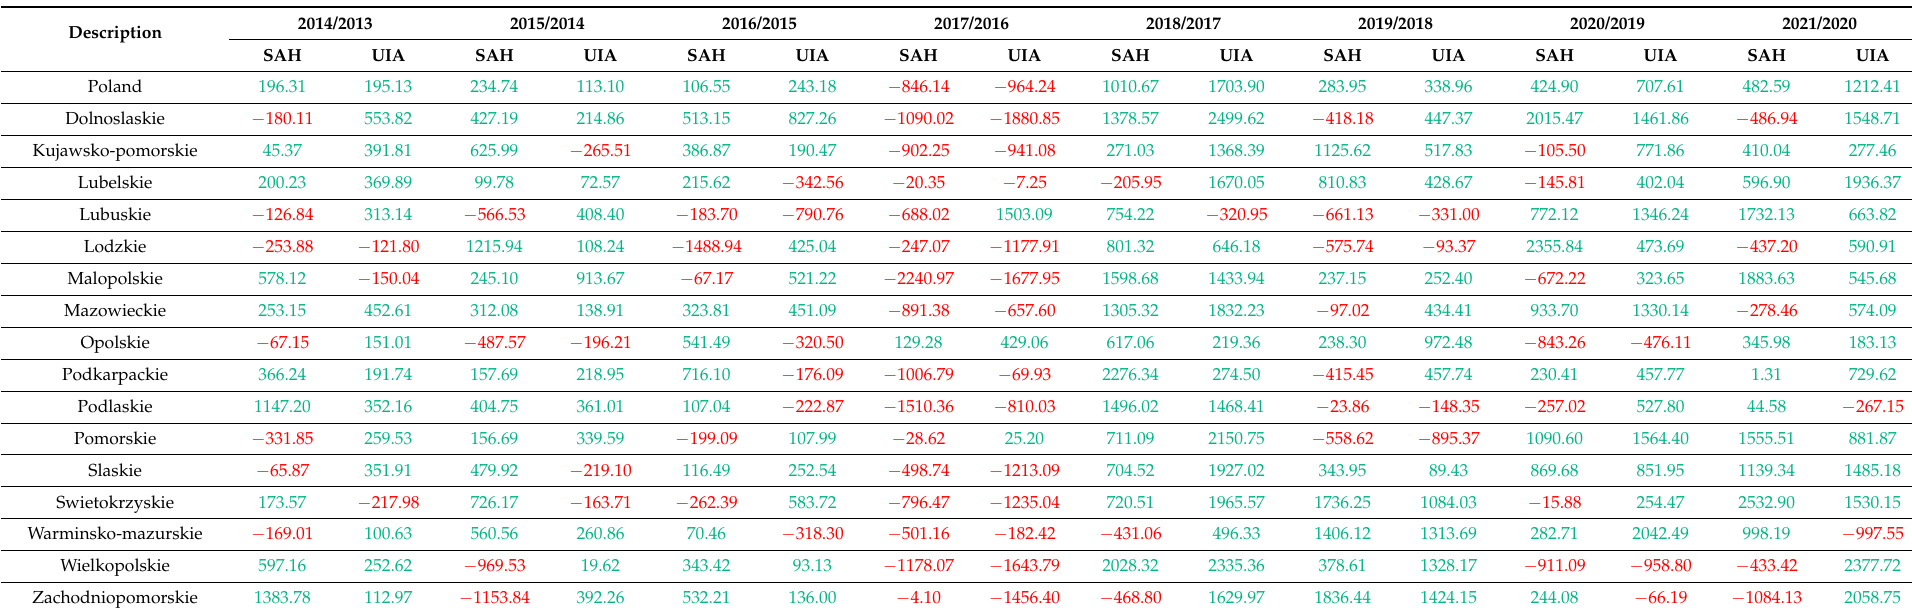
Table A3. Changes in levels of reported value of services per patient in PPP value terms (USD PPP) by province from 2013 to 2021 in total and for SAH and UIA